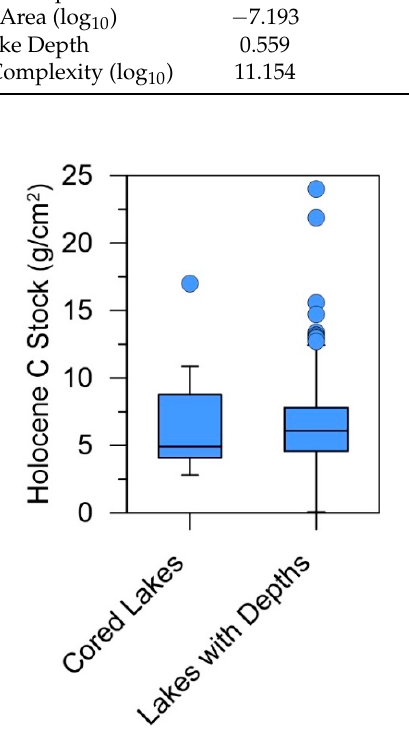
Figure 8. Boxplot comparing Holocene carbon stock in the 19 cored lakes with the stock estimated in the 414 lakes for which depth data are available.